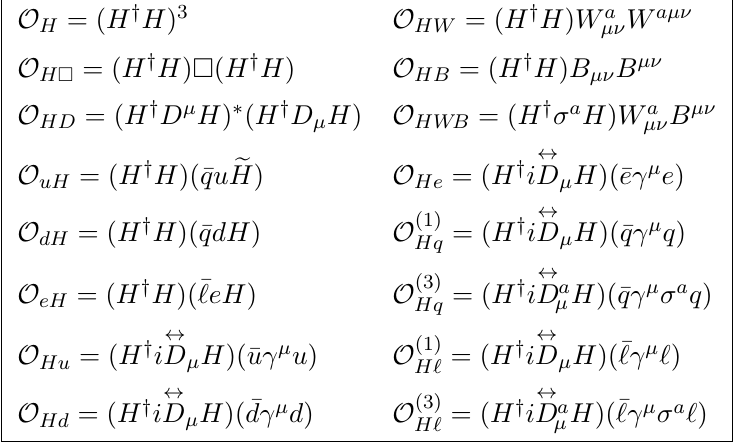
Table 1 . The relevant subset of dimension-6 SMEFT operators in the Warsaw basis generated by integrating out a heavy singlet scalar at one loop. Here the (cid:27) a are the Pauli matrices, and $ $ D a (cid:17) D (cid:22) (cid:27) a . (cid:22) O = (cid:3) H y (cid:3) H K 4